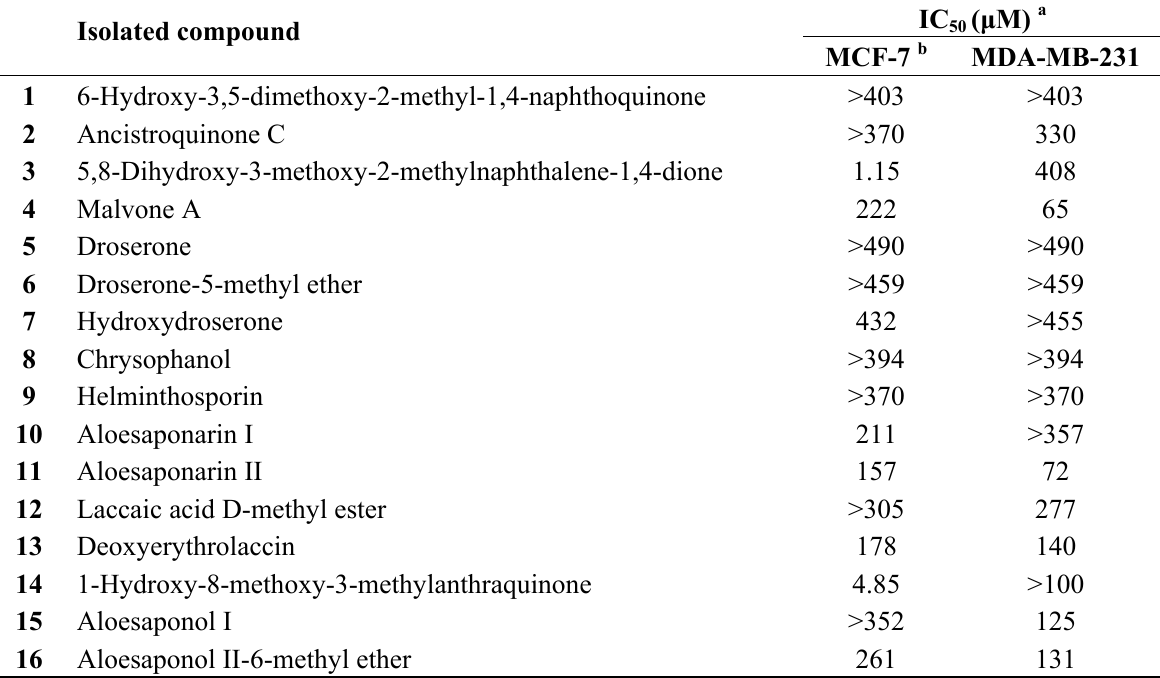
Table 2. Cytotoxicity of the roots constituents of Aloe dawei